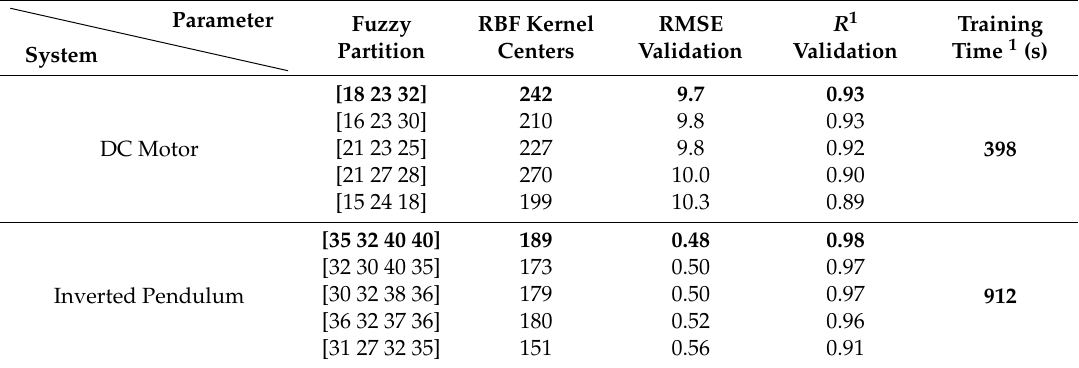
Table 2. Specifications and statistics between the top performing trained RBF